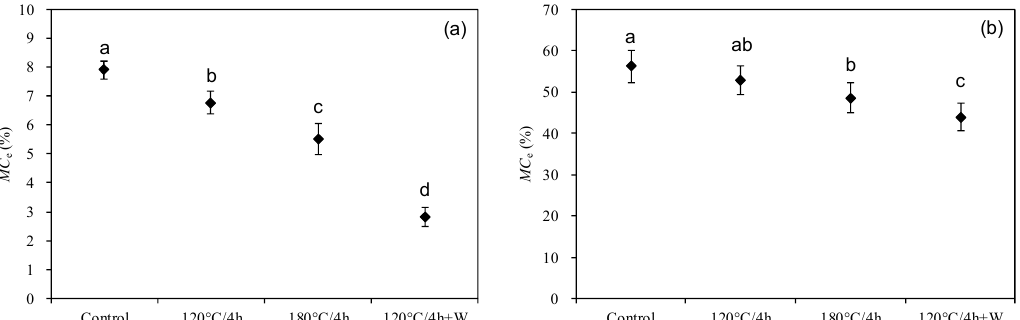
Figure 1. Moisture content of the control and treated wood: adsorption ( a ) and liquid water uptake ( b ). Bars with different letters present significant difference ( p < 0.05) in accordance with Duncan’s multiple range tests. Note: There are no significant differences between groups containing the same letters. The bar with ab means that there are no significant differences between this group and groups labeled with a or b.